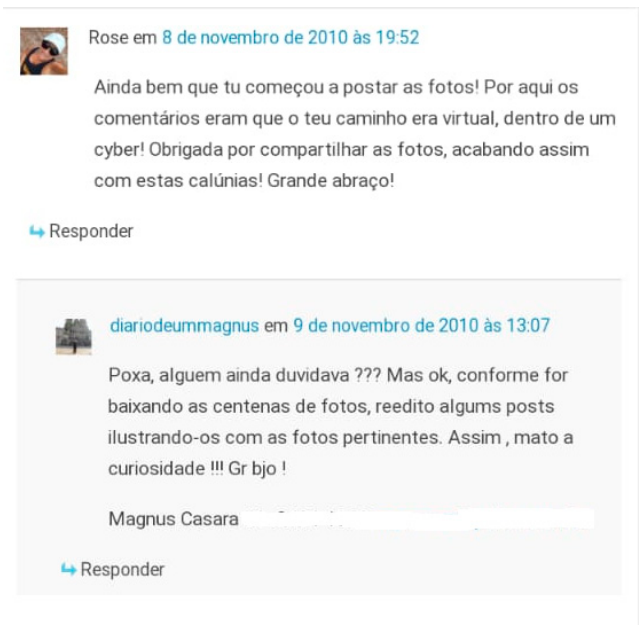
Figure 1. Comment on a pilgrim’s blog (The daily blog of Magnus). translation in Box 1. Box 1. Transcription of the dialogue in Figure 1.